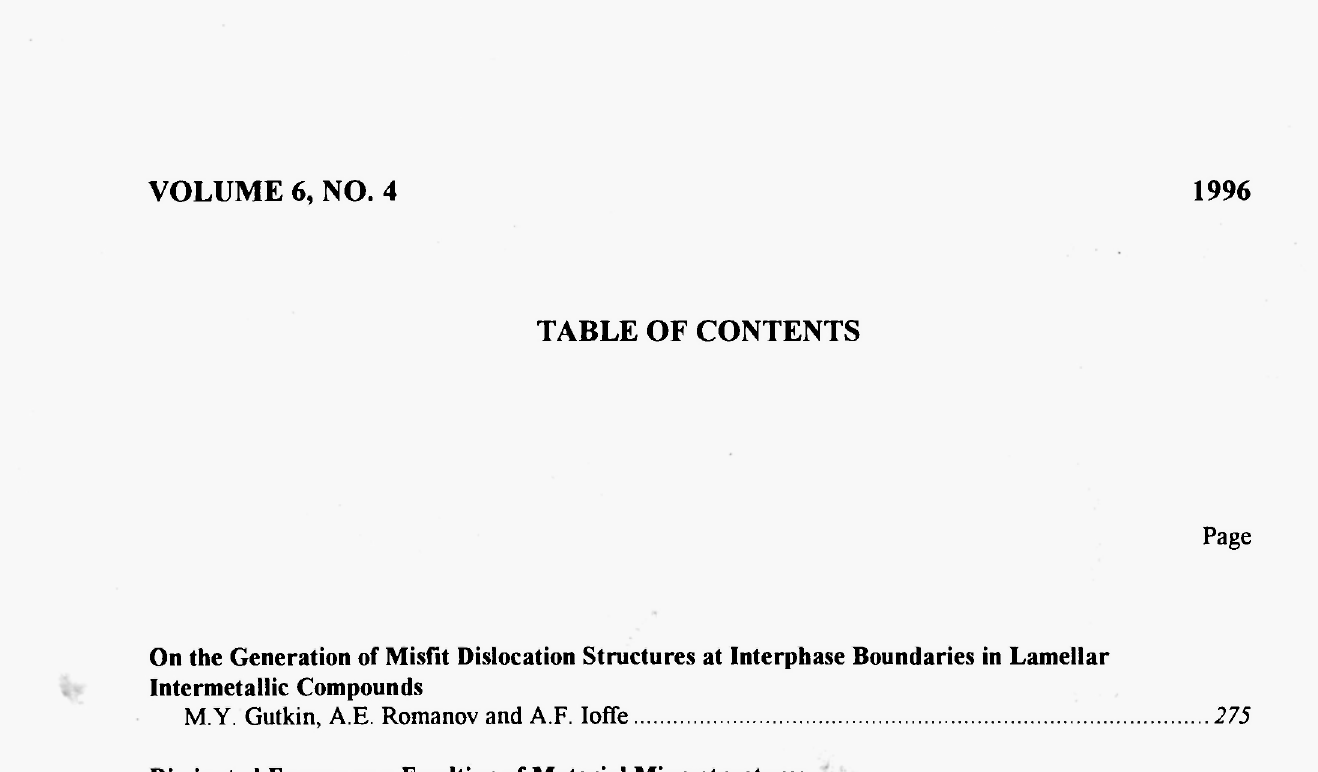
Failure of Notched CFRP Laminates Due to Fibre